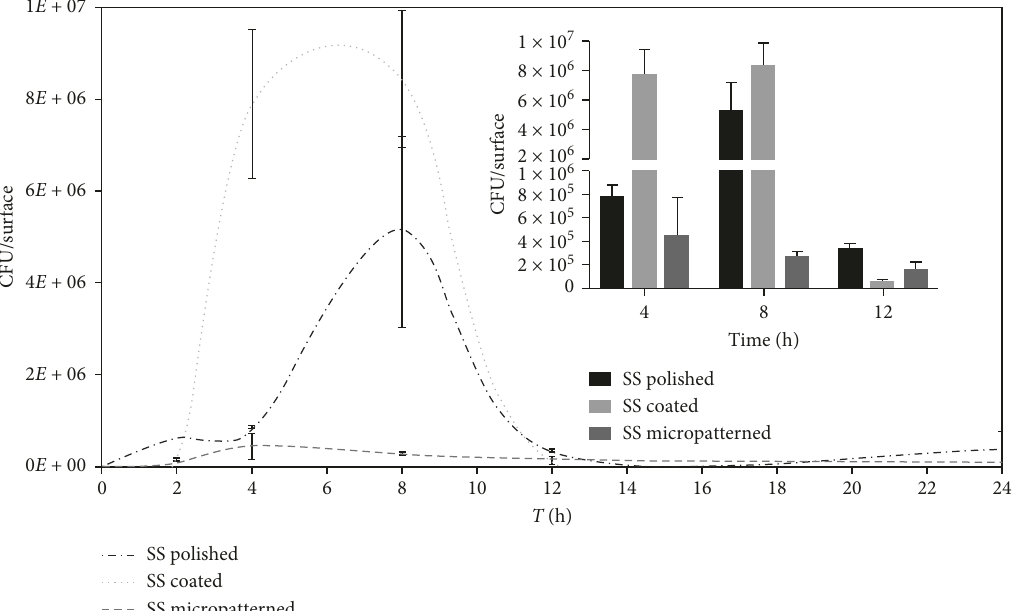
Figure 7: Bacterial adhesion and colonization at the different times. The inset figure shows bacterial adhesion at 4, 8 and 12 h, with maximum adhesion at 8 h.